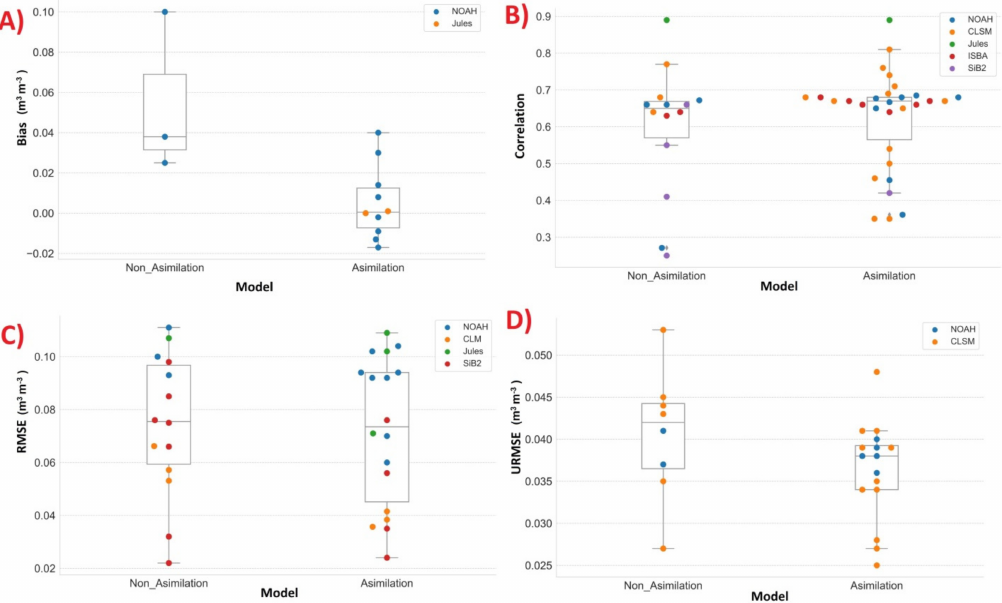
Figure 10. Assimilation results for RSM: ( A ) bias (m3 m-3), ( B ) correlation, ( C ) RMSE (m3 m-3), and ( D ) uRMSE (m3 m-3); the metrics are computed based on estimated SM in LSMs and ground networks. and non-assimilation cases are reported (sorted based on correlation) for SSM (Figure